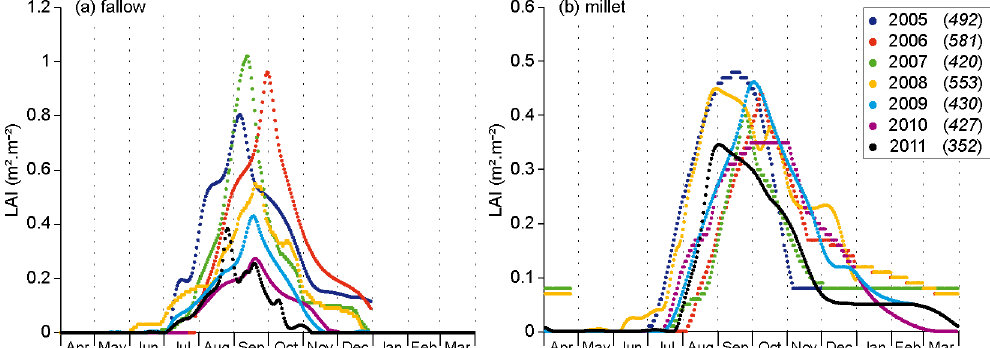
Figure 3. Seasonal course of daily LAI at (a) fallow and (b) millet plots for each growing season of 2005–2011 (in brackets: total rainfall, in millimeters).